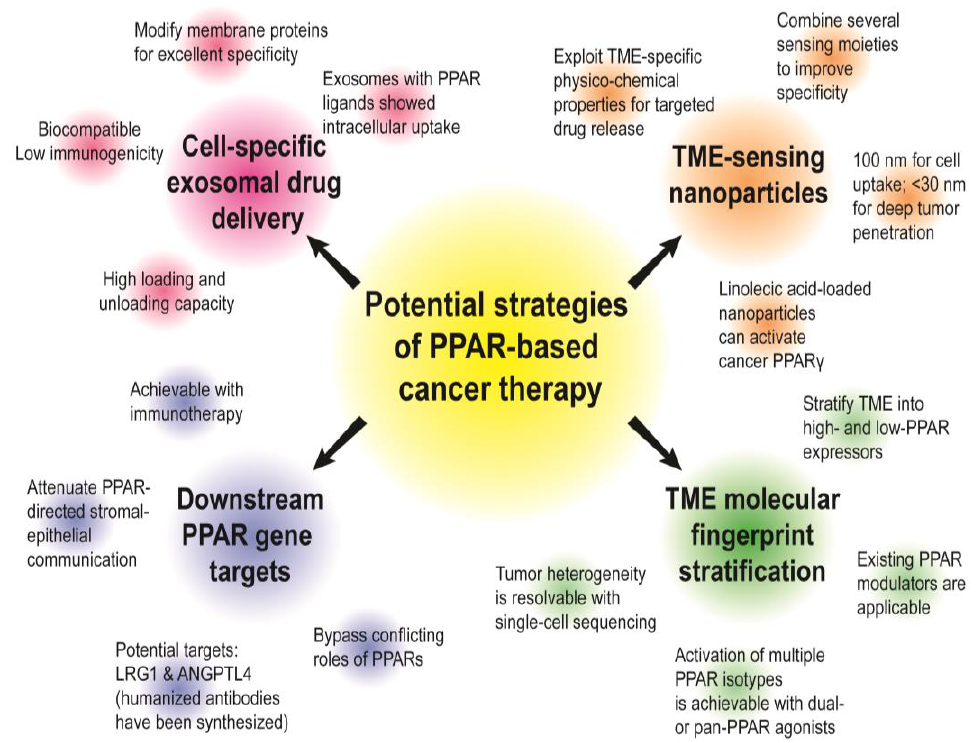
Figure 6. Possible strategies to target stromal PPARs for precision oncology. In this review, we propose four strategies to achieve PPAR-based precision oncology, including (i) cell-specific exosomes, (ii) TME-sensing nanoparticles, (iii) targeting pro-tumorigenic PPAR gene targets with immunotherapy, and (iv) stratification of PPAR-related TME molecular fingerprints. The features of each strategy are summarized in the figure.